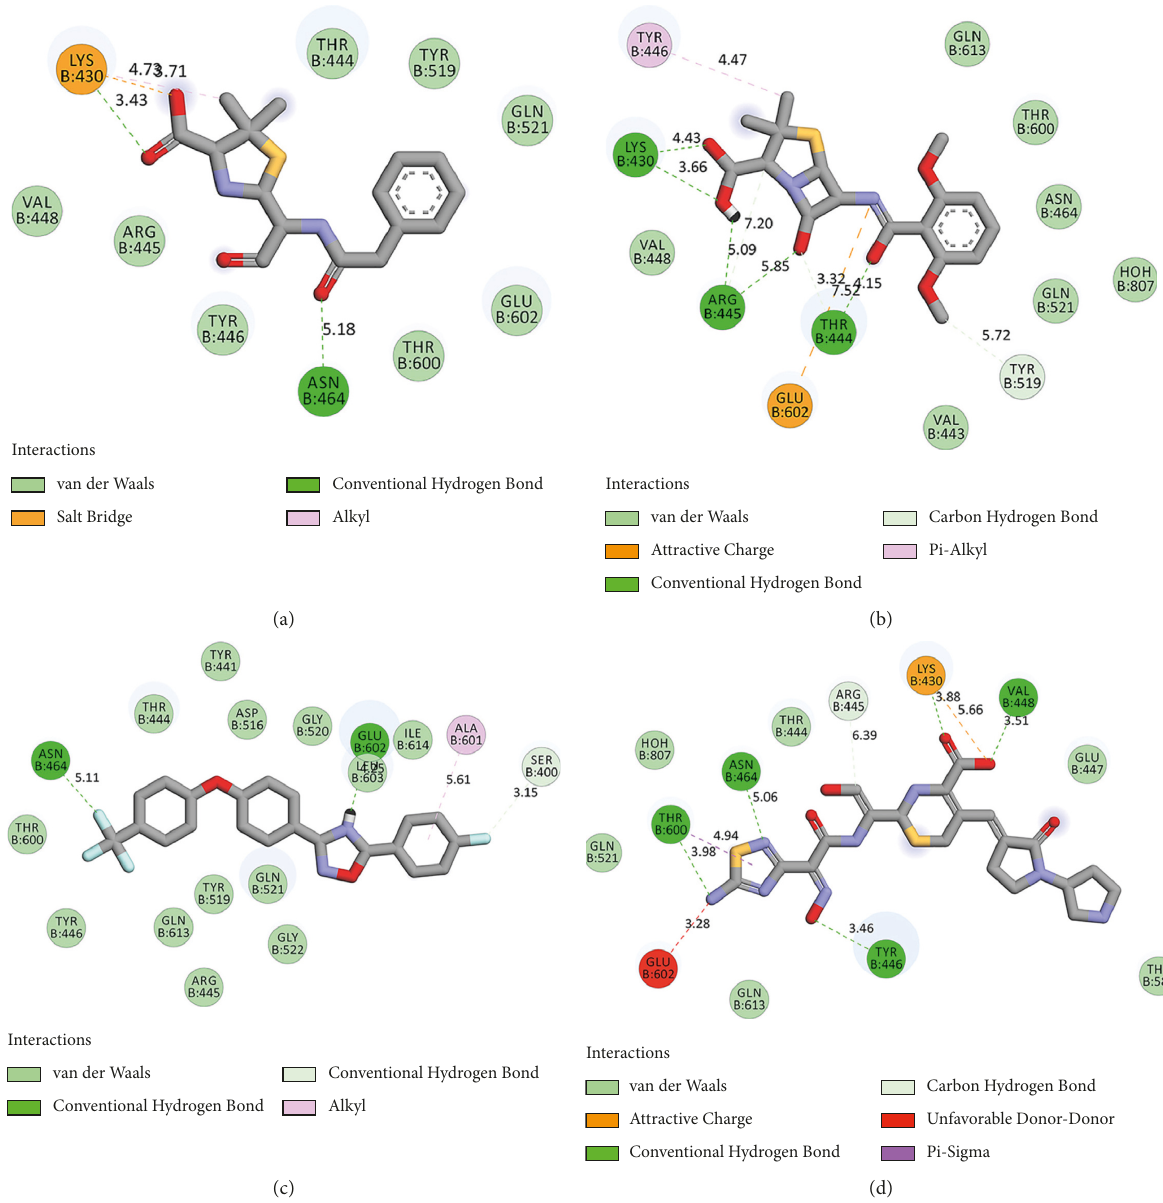
Figure 4: Interaction modes between residues inside the SauPBP2a active site and control positive and negative compounds. (a) Penicillin G, (b) methicillin, (c) oxadiazole, and (d) ceftobiprole. SauPBP2a, Staphylococcus aureus penicillin-binding protein